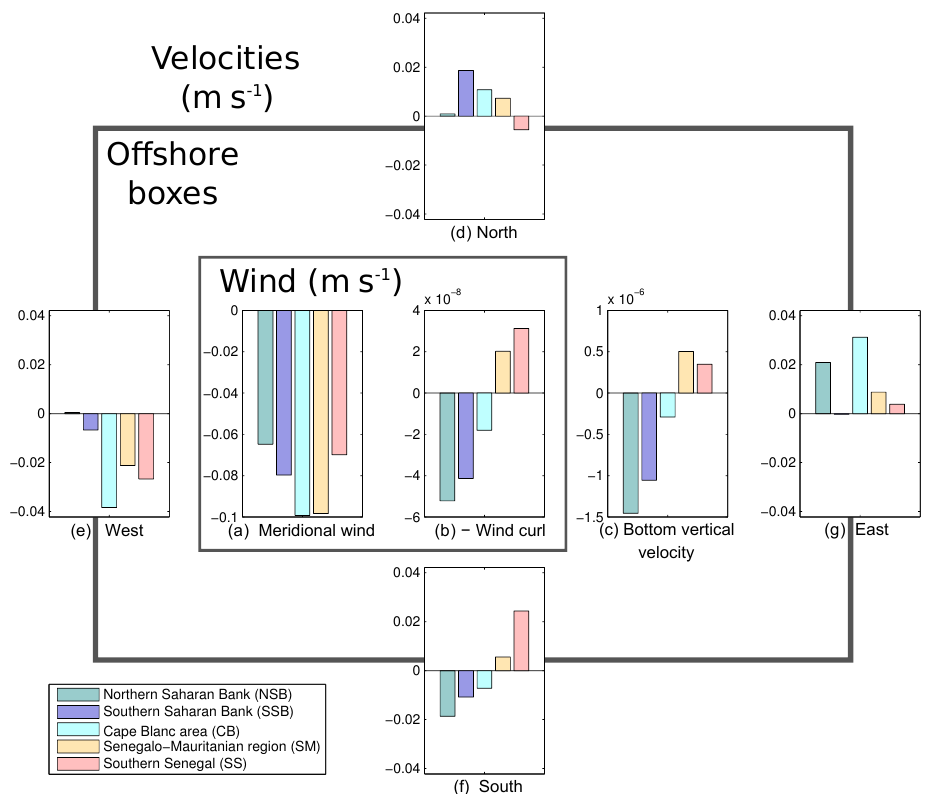
Figure 8. Spring mean (March–May) of (a) wind intensity (ms − 1 ) and (b) wind curl (s − 1 ) at the surface of the offshore boxes and (c) upwelling intensity (bottom vertical velocity, in ms − 1 ) within the offshore boxes and lateral velocities at the (d) northern, (e) western, (f) southern and (g) eastern boundaries (ms − 1 ) . Vertical and lateral velocities are defined as positive inward and upward. Each colour corresponds to a box (see